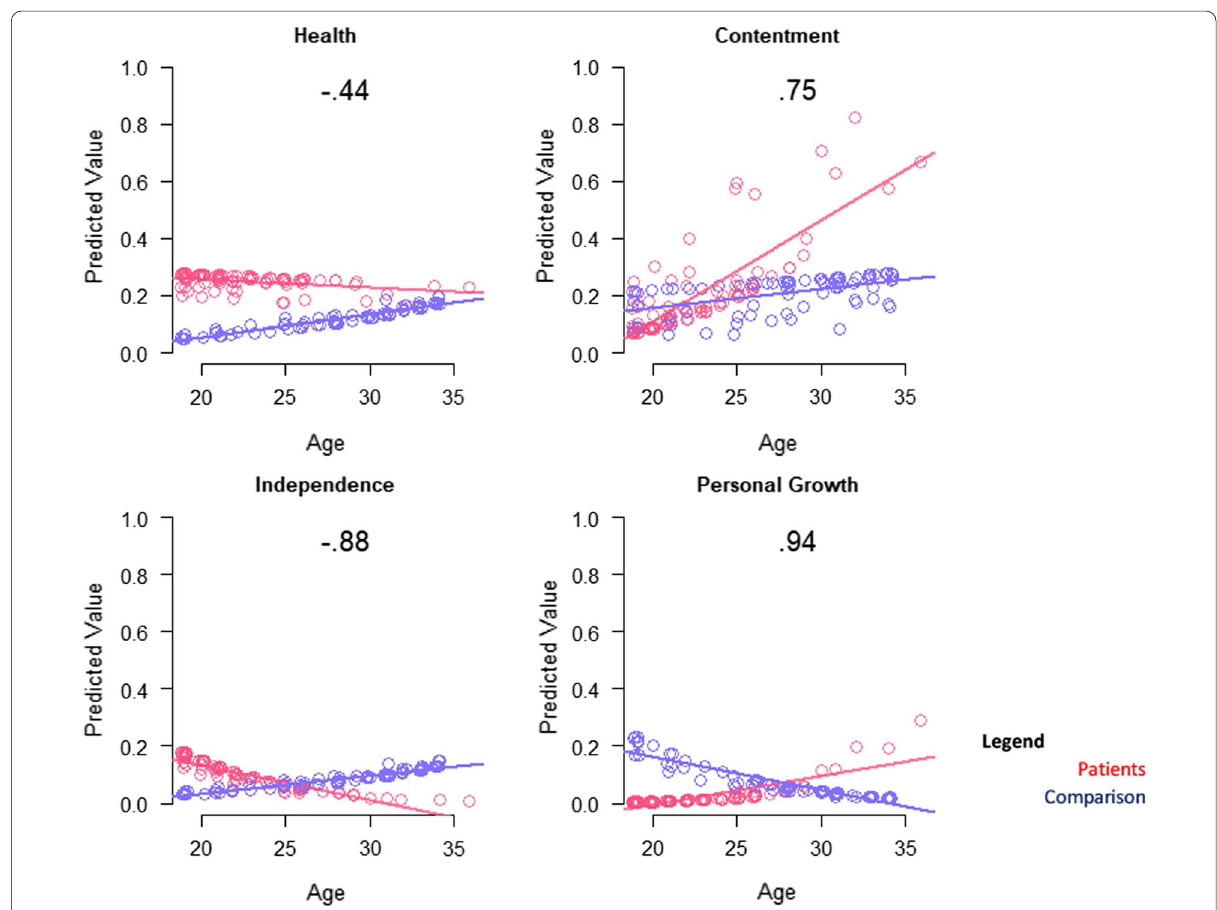
Fig. 3 Interaction plots for adjusted logistic models predicting QOL definition themes. Role-group differences for medium- and large-ES interaction effects are shown. Patient predicted values are shown in red; comparison in